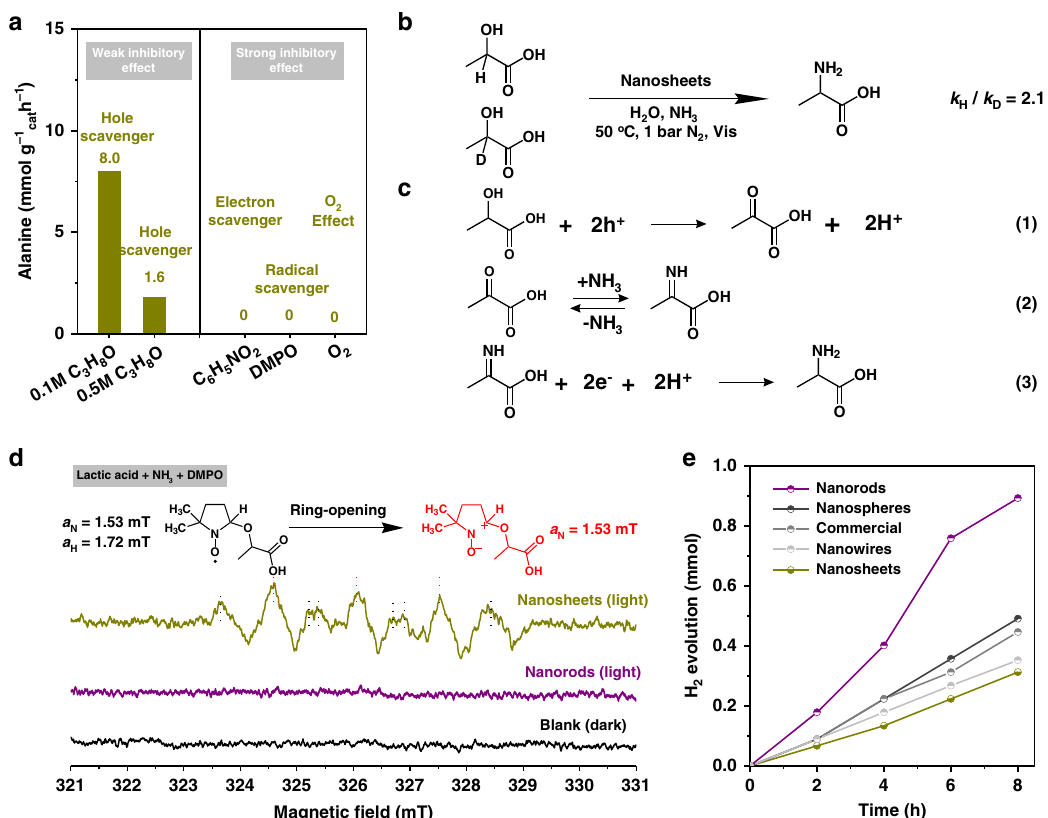
Fig. 4 Mechanistic insights for photocatalysis amination of lactic acid to alanine. a Control experiments with different scavengers and gas. Reaction conditions: 10 mg nanosheets, 20 mmol lactic acid, 2 mmol scavenger, 4 mL ammonia solution (25 wt%), 16 mL deaerated water, T = 50 °C, 1 bar N 2 or O 2 , and t = 4 h. b Isotope experiments. Reaction conditions: 10 mg nanosheets, 20 mmol lactic acid or lactic acid-d 1 , 4 mL ammonia solution (25 wt%), 16 mL deaerated water, T = 50 °C, 1 bar N 2 , and t = 4 h. c Equations for photocatalysis amination of lactic acid to alanine. d In situ ESR spectra for CdS nanosheets and nanorods in a mixture solution of lactic acid and ammonia in the presence of spin-trapping agent 5, 5-dimethyl-1-pyrroline N-oxide (DMPO) with or without visible-light irradiation. e H 2 evolution experiments. Reaction conditions: 10 mg CdS, 20 mmol lactic acid, 20 mL deaerated water, T = 50 °C, and